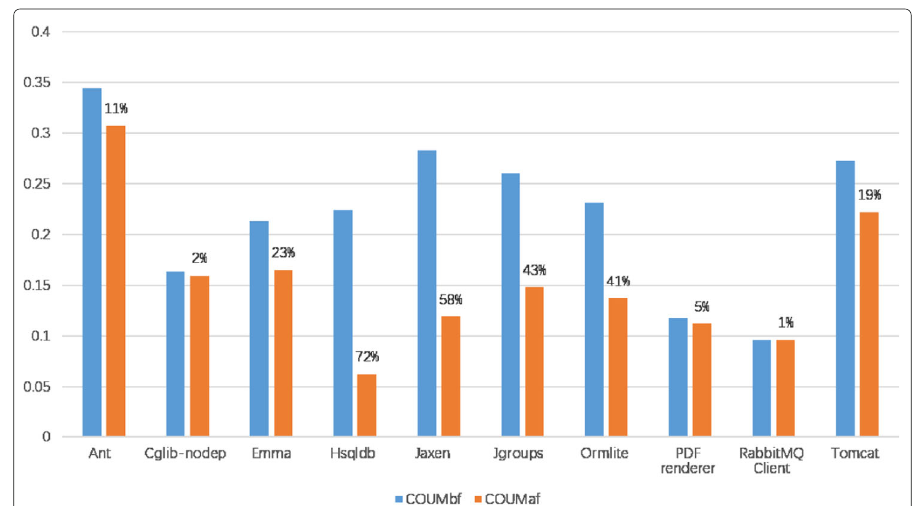
Fig. 4 The change of COUM after refactoring. COUMbf denotes the COUM value of the entire software before refactoring. COUMaf denotes the COUM value of the entire software after refactoring